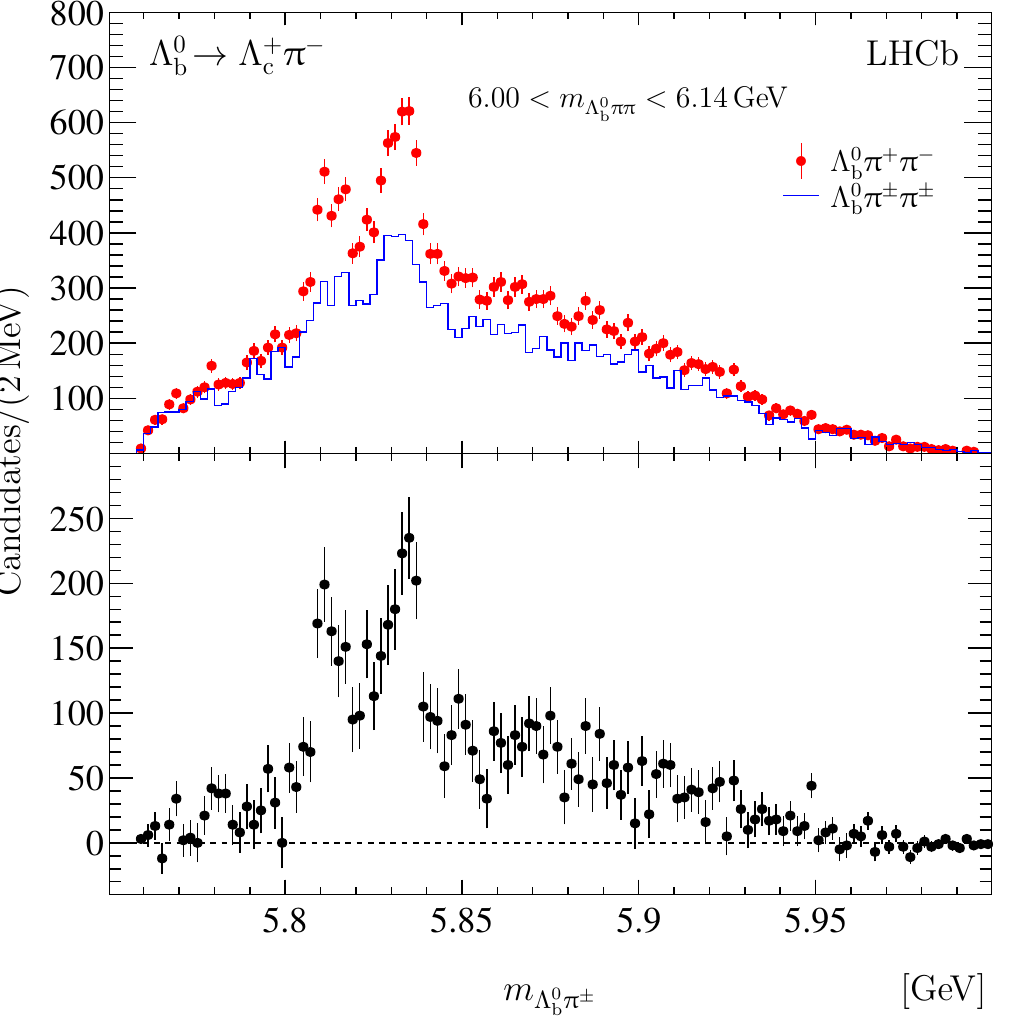
Figure 4 . (Top) Spectra of (cid:3) 0